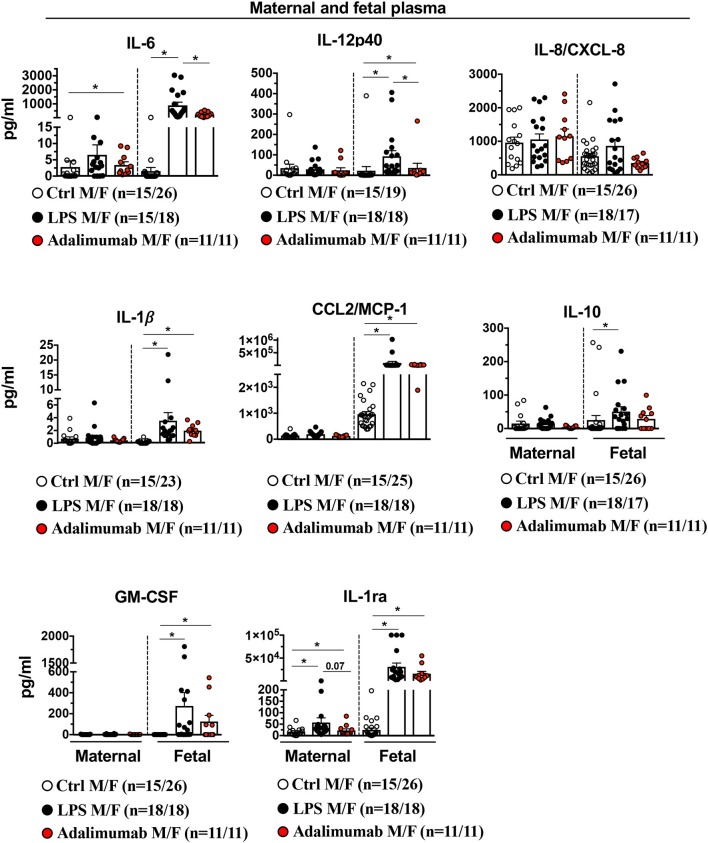
Adalimumab decreased partially inflammation in fetal plasma. Cytokine concentrations were measured in maternal and fetal plasma by multiplex ELISA. There was a minimal increase in cytokines in maternal plasma after IA LPS. In the fetal plasma, Adalimumab significantly decreased LPS-induced IL-6, and IL12p40, but not IL-8/CXCL8, IL-1β, CCL2/MCP1, IL10, GM-CSF, and IL-1ra (Maternal plasma: Ctrl n = 15; LPS n = 15–18; Adalimumab n = 11; Fetal plasma: Ctrl n = 19–26; LPS n = 17–18; Adalimumab n = 11). M, Maternal; F, Fetal. Data are mean ± SEM, *p < 0.05 between comparators by Mann-Whitney U-test.